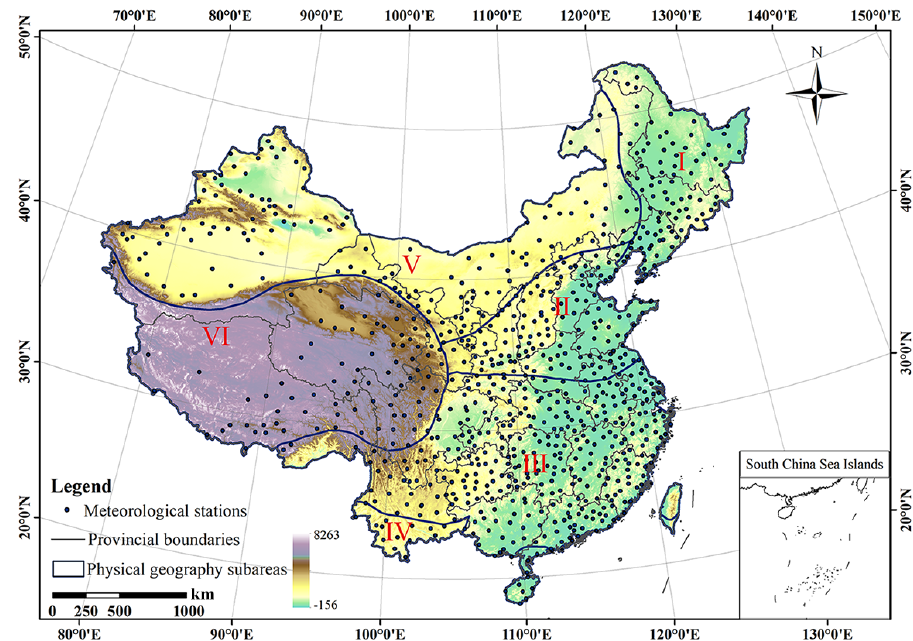
Figure 1. Scope map of the total study area and the six subregions. Black dots indicate distribution locations of meteorological stations; blue frame lines indicate the substudy area range, represented by I, II, III, IV, V, and